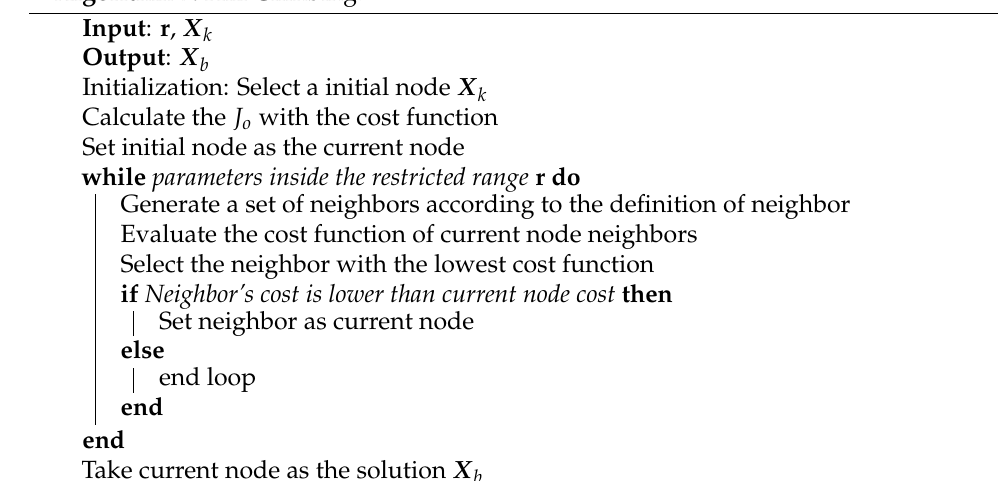
Algorithm 7: Hill